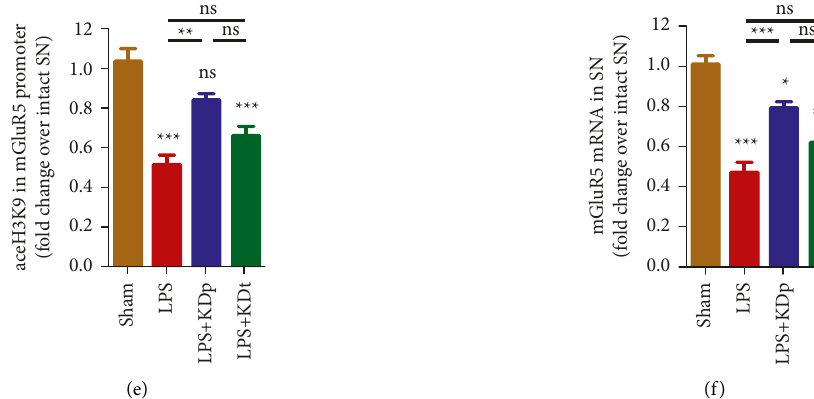
Figure 5: The changes of mGluR5 and TSPO expression induced by LPS and KD in SN. The numbers of mGluR5 + microglia cells (a, c), TSPO + microglia cells (b, d), and the levels of aceH3K9 in mGluR5 promoter region (e) and mGluR5 mRNA expression (f) were compared among multiple groups. Data were presented as the mean ± SEM. ∗∗∗ P < 0 . 001; ∗∗ P < 0 . 01; ∗ P < 0 . 05; LPS, lipopolysaccharide; KDp, preventive intervention with KD prior to the PD onset; KDt, therapeutic intervention with KD after the PD onset.